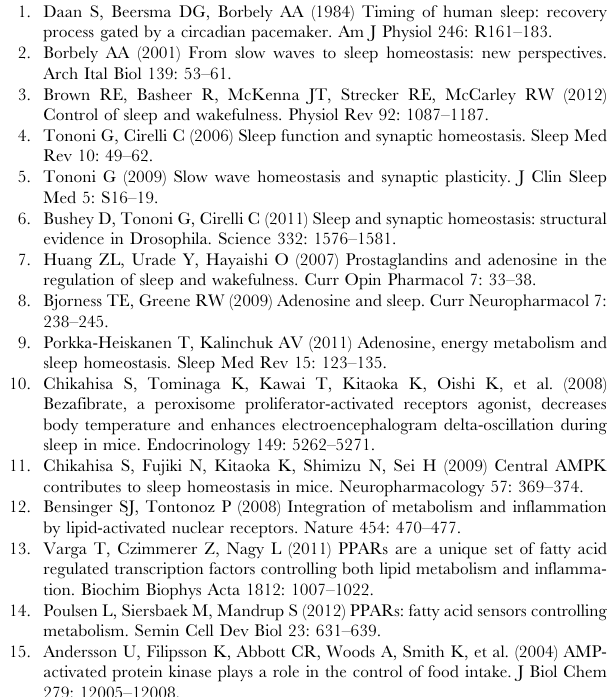
Figure S7 Gene expression related to the feeding regulation (A) and the regulation of glucose metabolism (B) such as hexokinase 1 (HK1, encoded by Hk1 ), hexokinase 2 (HK2, encoded by Hk2 ), phosphofructokinase, muscle (PFKM, encoded by Pfkm ), solute carrier family 2, member 1 (SLC2A1, encoded by Slc2a1 ), solute carrier family 2, member 3 (SLC2A3, encoded by Slc2a3 ), lactate